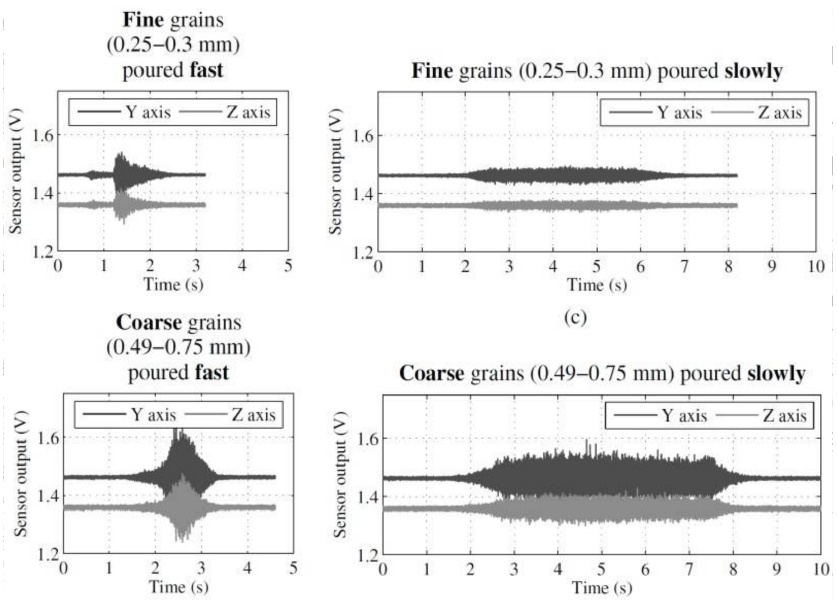
Figure 8. Example of waveforms acquired in two axes of accelerometer for fine and coarse grains transported with two